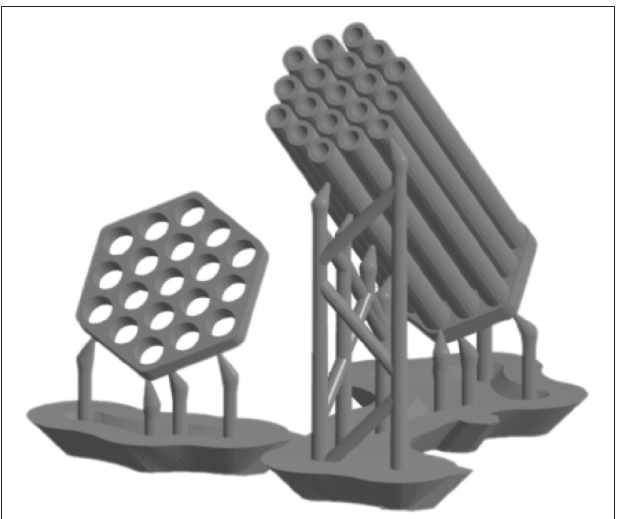
FIGURE 8 | Test print with 19 tubes and the support structures for printing. Left: movable grid. Right: Tubes and base plate combined. The automatically generated support structures were designed with minimum density and minimum recommended point size.